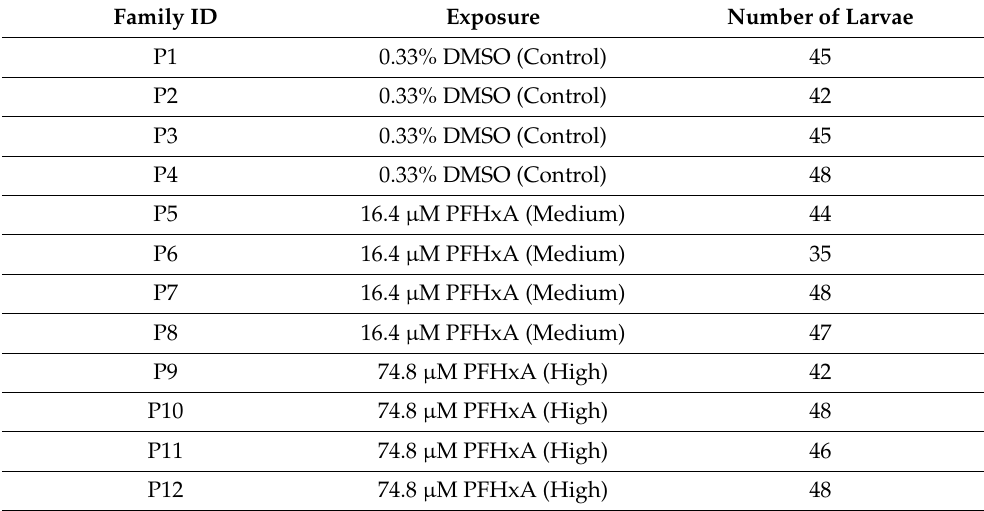
Table 2. Breakdown of counts of zebrafish larvae remaining from each pair spawn (Family ID). There were 3 exposure groups–4 pairs / exposure, 12 groups in total) after